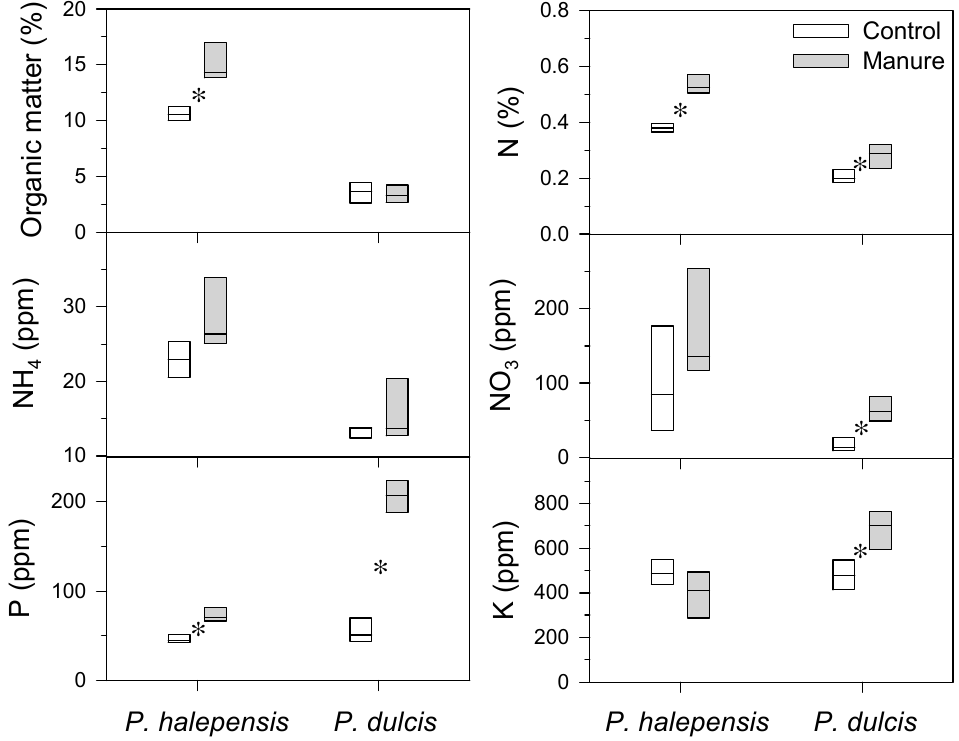
Figure 1. Differences between control (empty box-plots) and manure-applied (filled box-plots) trees of the two study species in soil chemical characteristics. Asterisks indicate significant ( p < 0.05) differences between groups according to t tests.